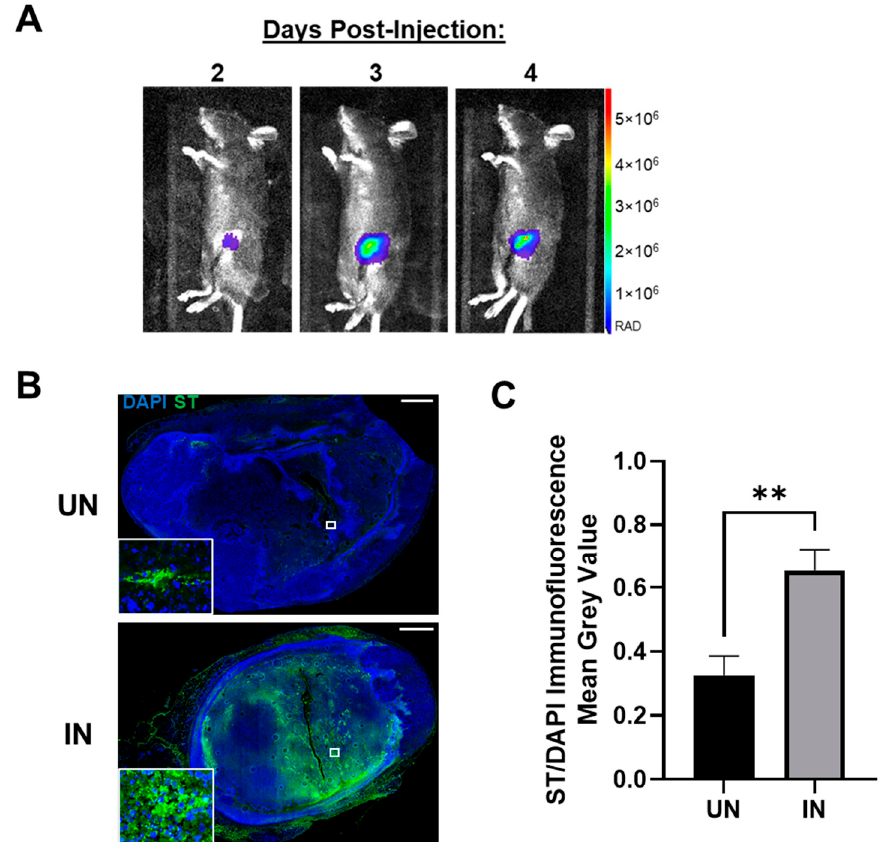
Figure 4. YS-HAse preferentially and specifically colonizes EO771 tumors in vivo. ( A ) Tumor col- onization by YS1646. C57BL/6 mice bearing orthotopic EO771 tumors (>150 mm 3 ) were administered 5 × 10 6 colony-forming units (cfu) of YS1646 expressing luciferase (YS-LUX) by intravenous (i.v.) injection. Intravital imaging was performed 2, 3, and 4 days post-injection using IVIS. Representative images are shown. ( B ) Immunofluorescence (IF) staining of YS-HAse-treated tumors. C57BL/6 mice bearing orthotopic EO771 tumors (~100 mm 3 ) were i.v. administered 5 × 10 6 cfu of YS-HAse per day over two days ( n = 5). Forty-eight hours after the first dose, the groups were intraperitoneally (i.p.) administered PBS (UN) or 150 mg L-arabinose (IN) and then euthanized 24 h post-induction. Serial tumor sections were then subjected to IF staining to detect YS-HAse (ST) using the HA-binding protein (HABP) and anti-ST 0–4 primary antibody, followed by fluorescence-conjugated secondary antibodies. All images are representative of ≥ 3 experiments. Scale bar = 1000 µ m. ( C ) The quantifica- tion of ST per area was approximated by dividing the mean grey value (MGV) of the ST signal by the MGV of DAPI. The MGV was measured using ZEN Blue software. ** p < 0.01, t